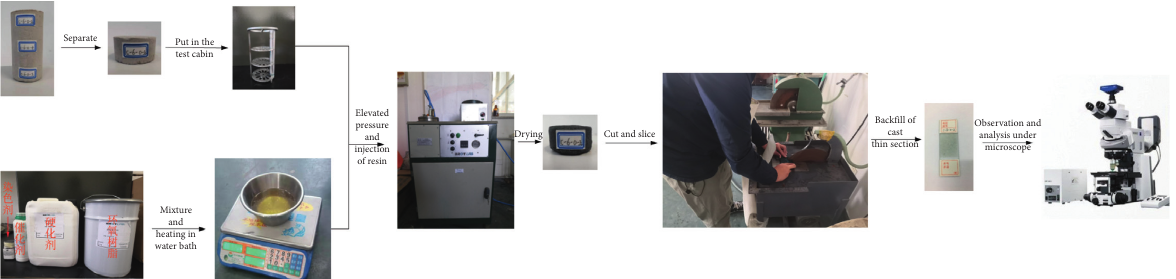
Figure 4: Flowchart of lipid injection